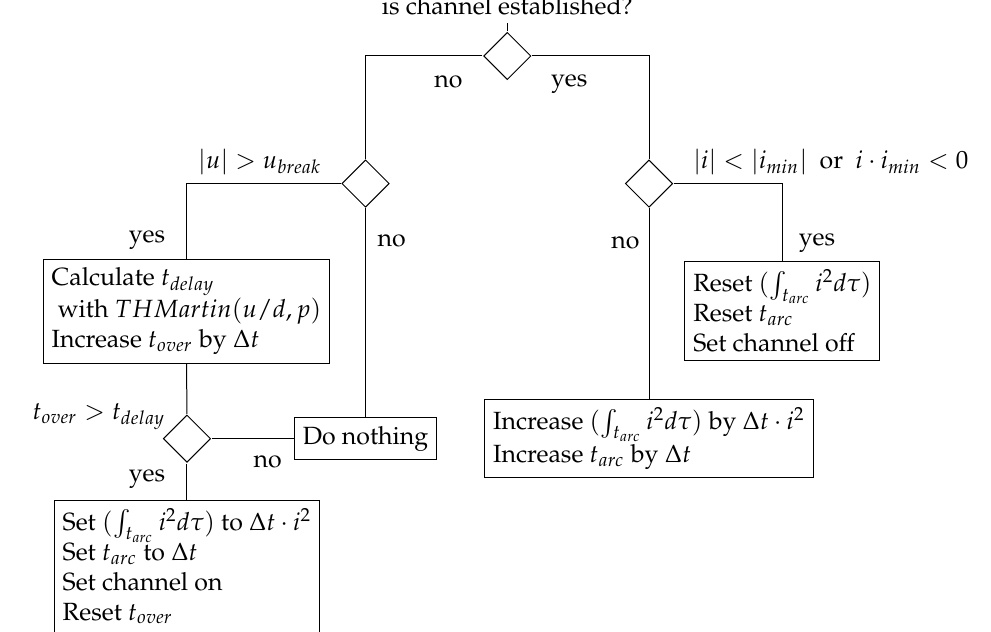
Figure 2. Diagram of the procedure for advancing the state of a realistic spark-gap Contrary to most switches implemented in SPICE simulators, the SW switch is 131 executed as a conditional statement that instantaneously connects the nonlinear resistor 132